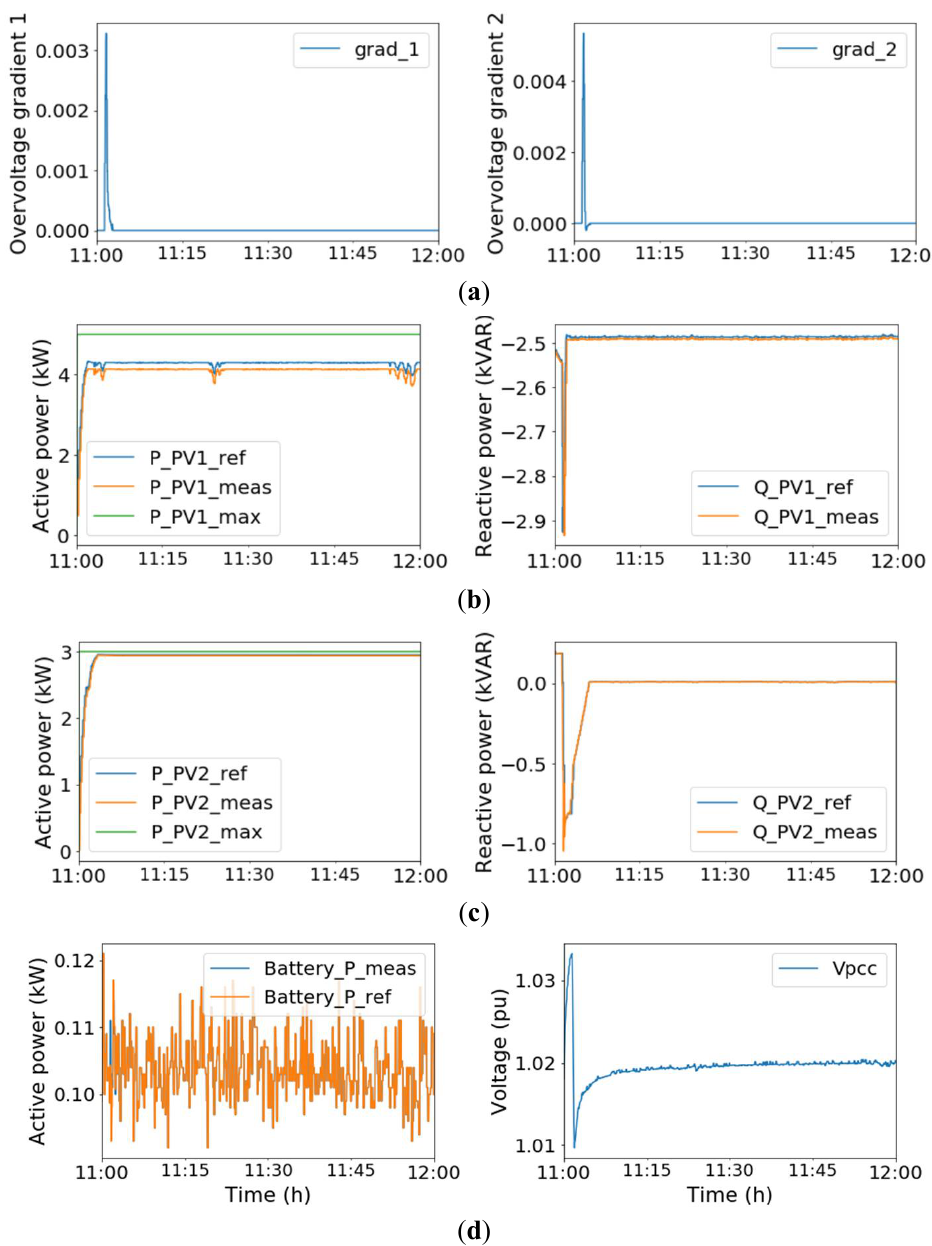
Figure 17. Results of hardware Heila DER local controller for Rack 1: ( a ) the dual variables received from the Heila coordinator; ( b ) the optimal power set points and measurements of PV inverter 1; ( c ) the optimal power set points and measurements of PV inverter 2 and ( d ) the optimal power set points and measurements of the battery inverter ( left ) and the PCC voltage of Rack 1 ( right ).